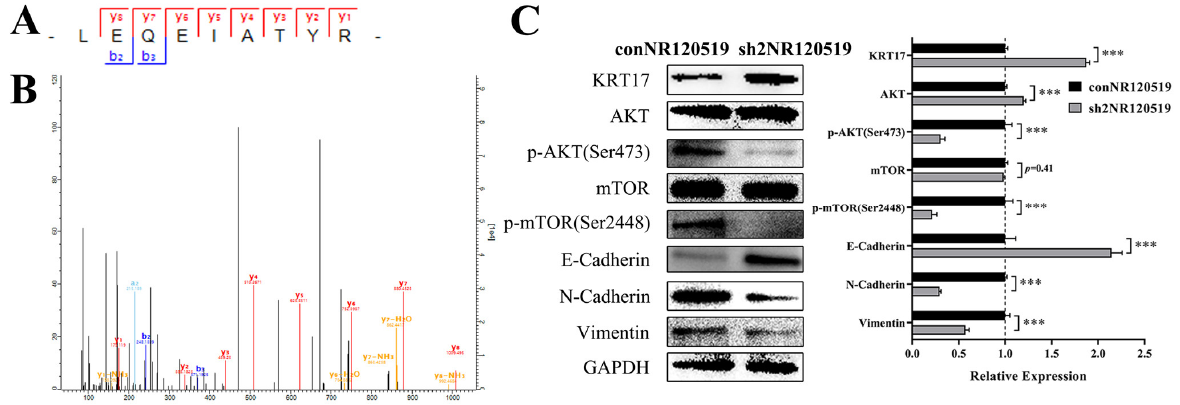
Figure 3. NR120519 repressed KRT17 expression and activated the AKT/mTOR and EMT pathways. ( A ) The ions determining the position of KRT17 in the RNA pulldown assay of NR120519. ( B ) Mass spectra of KRT17 protein after pulldown in the RNA pulldown assay of NR120519. ( C ) Western blotting experiments involving NR120519 control and knockdown (sh2NR120519) groups to detect the expression of KRT17, AKT/mTOR, and EMT pathway-related proteins. *** p < 0.001.